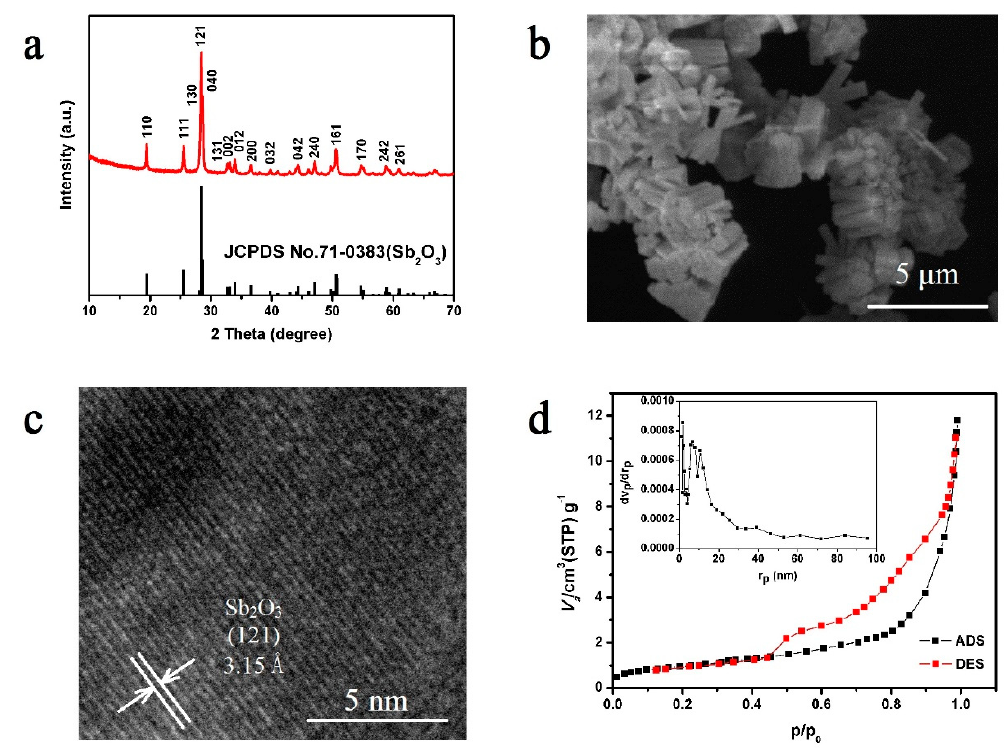
Figure 1. Characterization of as-synthesized Sb 2 O 3 sample: ( a ) X-ray di ff raction patterns; ( b ) scanning electron microscope image; ( c ) high-resolution transmission electron microscope image; ( d )